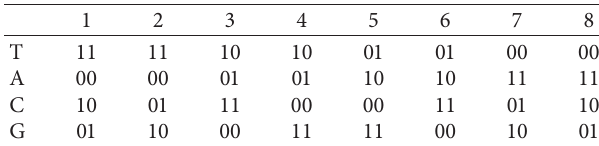
Figure 2: The phase diagram of Lorenz hyperchaotic map with r � − 1. Table 1: DNA encoding